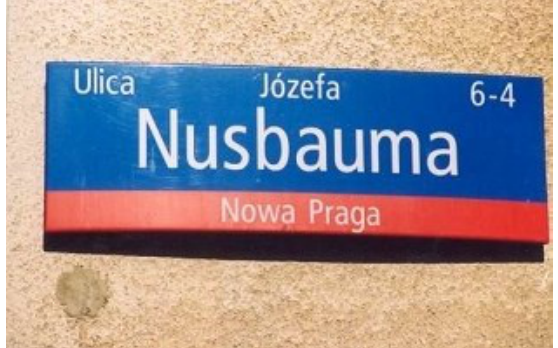
Figure 1. A street in Warsaw (Poland) is named after the famous Darwinist and comparative anatomist Józef Nusbaum (1859–1917) from the University of Lwów (today